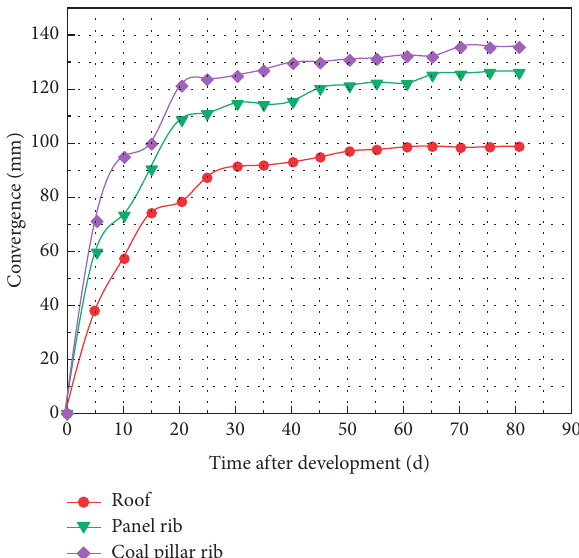
Figure 6: Deformation monitoring of the surrounding rock during roadway